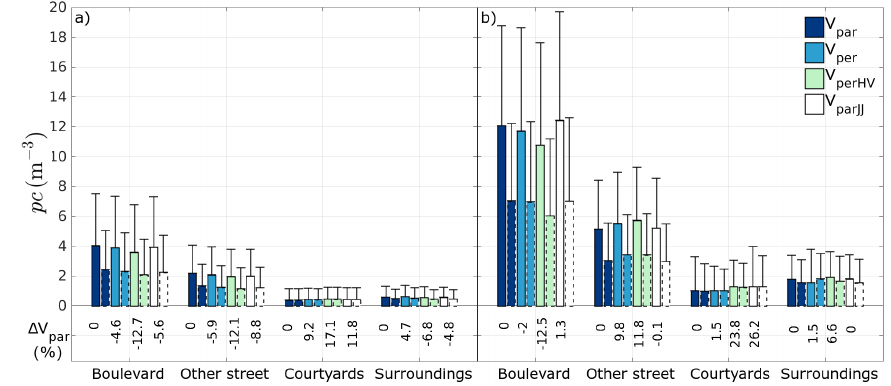
Figure A1. 40-min horizontal mean particle concentrations pc (m − 3 ) for the ( a ) neutral run with an easterly wind and ( b ) stable run with a southwesterly wind separately above the boulevard, other street canyons, courtyards and surroundings at height z = 4 m (bars with solid lines) and z = 10 m (bar with dashed lines) for all runs. 90th percentile values are given with errorbars. The mean difference to the values in V par is given in percentages ( ∆ V par ).